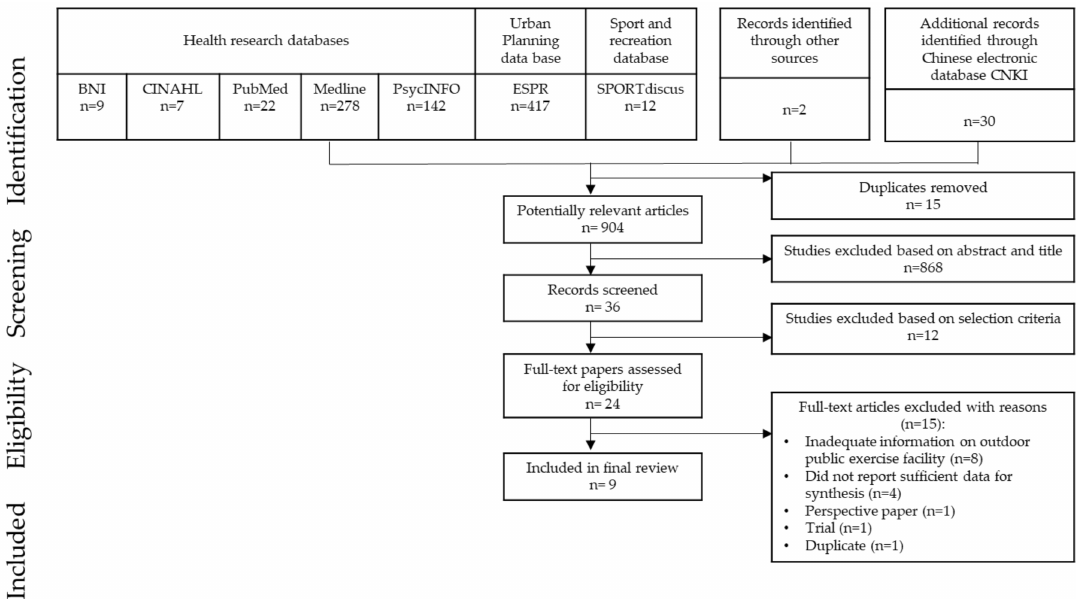
Figure 1. Flow chart of paper